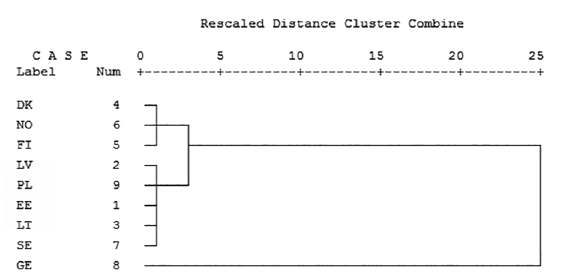
Fig. 3. Dendrogram representing the formation of countries’ clusters based on their railway transport flows during 2004–2007